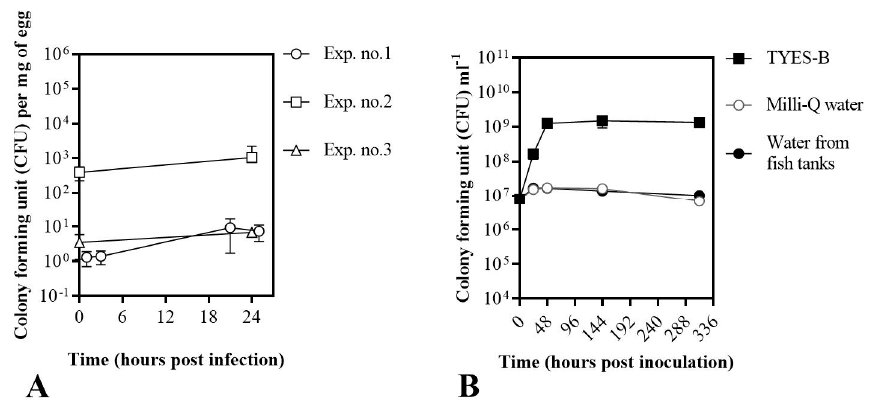
Figure 3. F. psychrophilum in connection with the eyed eggs in three independent experiments (section A) ( A ) and F. psychrophilum growth in Milli-Q and filter-sterilized water from fish tanks in comparison to TYES-B ( B ). In ( A ), values represent the mean and standard deviation of three biological replicates except in exp. no. 3 at 24 h post infection ( n = 2). Control eyed eggs (bathed with sterile TYES-B) were negative to the bacteria for each experiment. In ( B ), values represent the mean and standard deviation of two replicates.